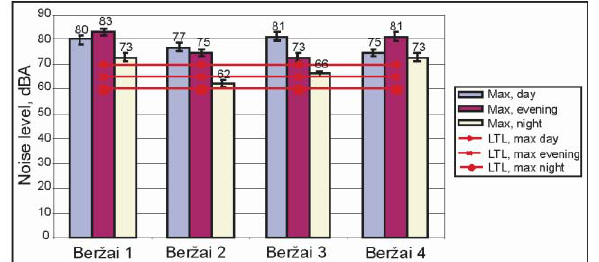
Fig. 5. Dynamics of maximum noise levels in Berţai street within twenty four hours